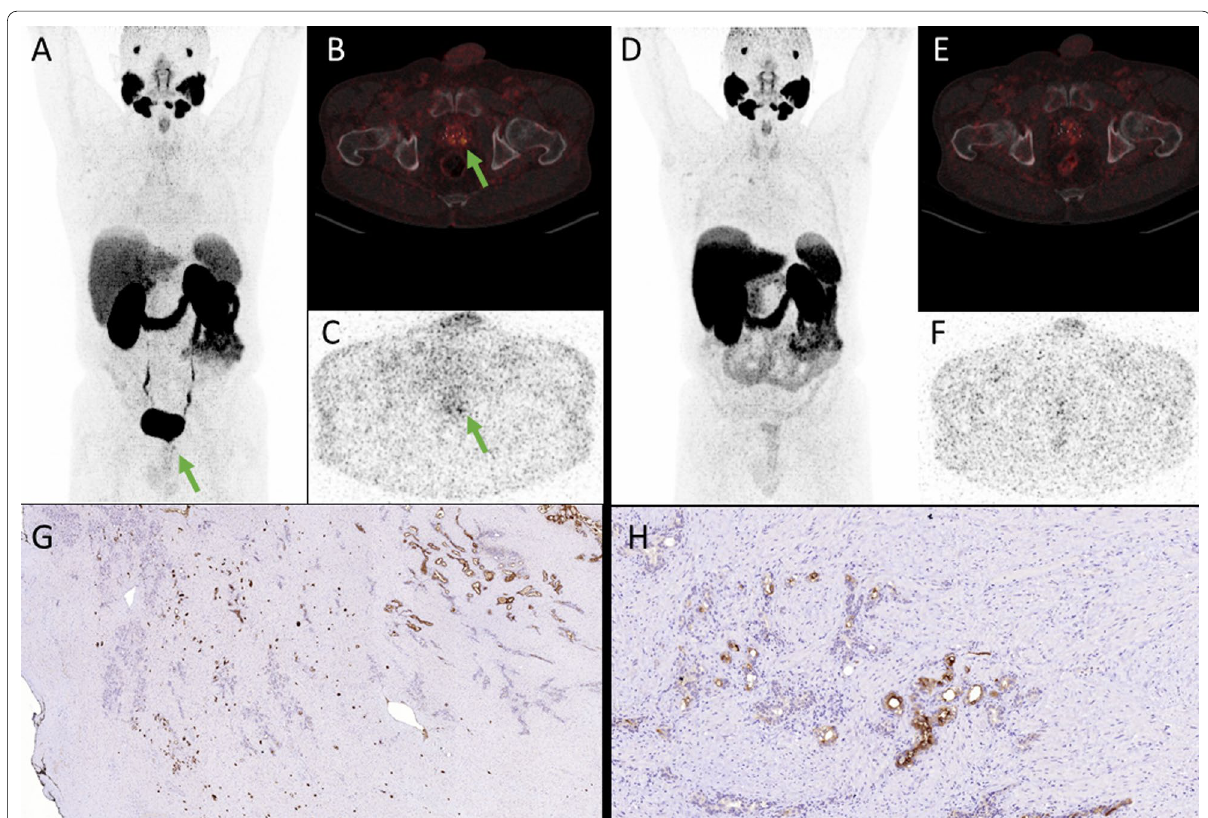
Fig. 2 MIP of [ 68 Ga]-Ga-PSMA-11 PET ( A ) with marginally positive (SUV max 7.7) oligofocal local recurrence after seed implantation in both the right and left dorsoapical prostate lobe (green arrow). The accumulation was retrievable in both the attenuation corrected fused axial slices ( B ) and in the non-attenuation corrected axial slices ( C ). In [ 18 F]-F-PSMA-1007 PET neither in the MIP ( D ) nor in the attenuation corrected fused axial slices ( E ) nor in the non-attenuation corrected axial slices ( F ) focal uptake was noted. Immunhistochemical images ( G , H ) show several, diffuse, small tumor cell nests with moderate to intense PSMA-expression